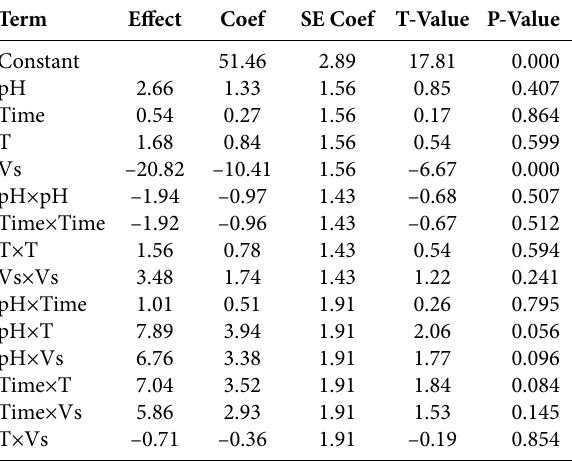
Table 3. Effects of the factors, coded coefficients (Coef), standard errors (SE) of the coefficients, t-values and p-values of the variables obtained by the CCD model.